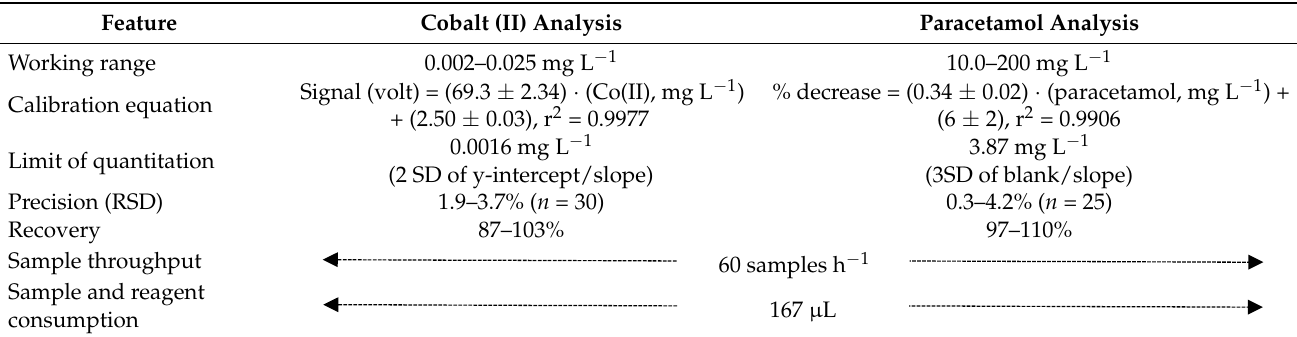
Table 1. Analytical features of the CL-CIA systems for Co(II) and paracetamol.